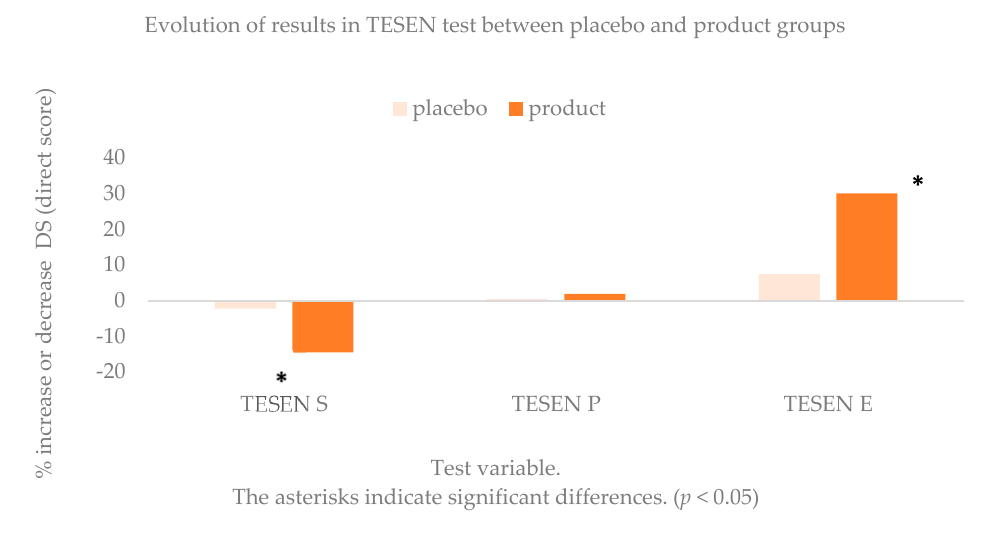
Figure 3. Evolution of results in the different variables of TESEN test in percentage increase or decrease. * indicate signif- icant differences. ( p < 0.05).